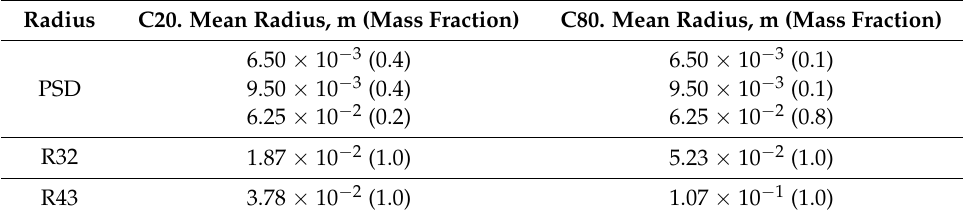
Table 6. Particle size distribution (PSD) and mean radii used in the simulations. The values in parenthesis indicate the mass fraction of the